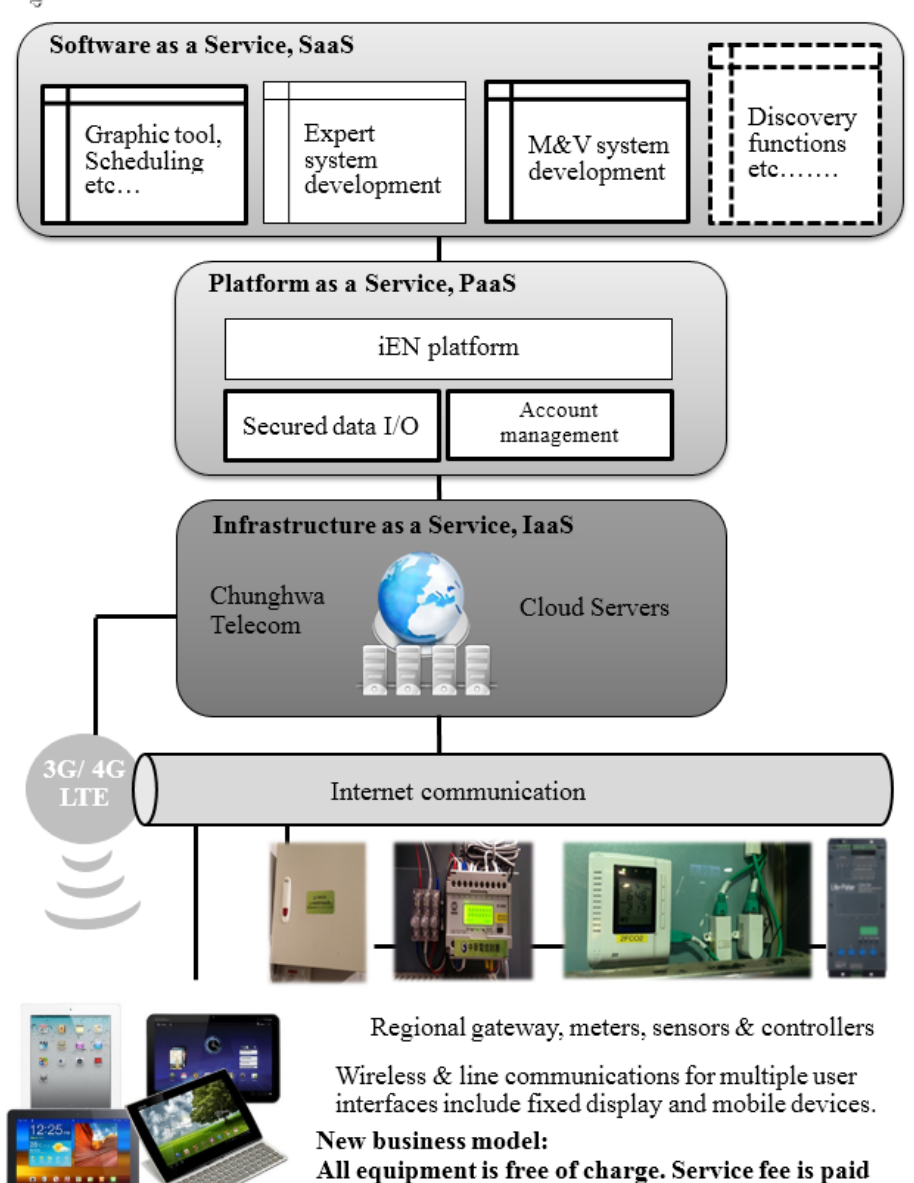
Figure 2. Cloud EMS and an iEN platform, consists of three service models, i.e. , SaaS, PaaS, and